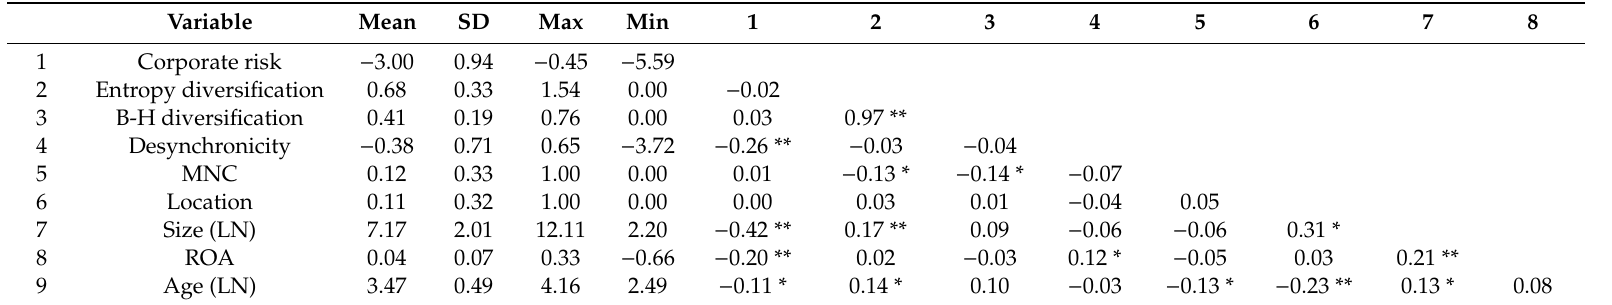
Table 2. Summary of Key Statistics and Correlations of Variables—relating SD of ROA to